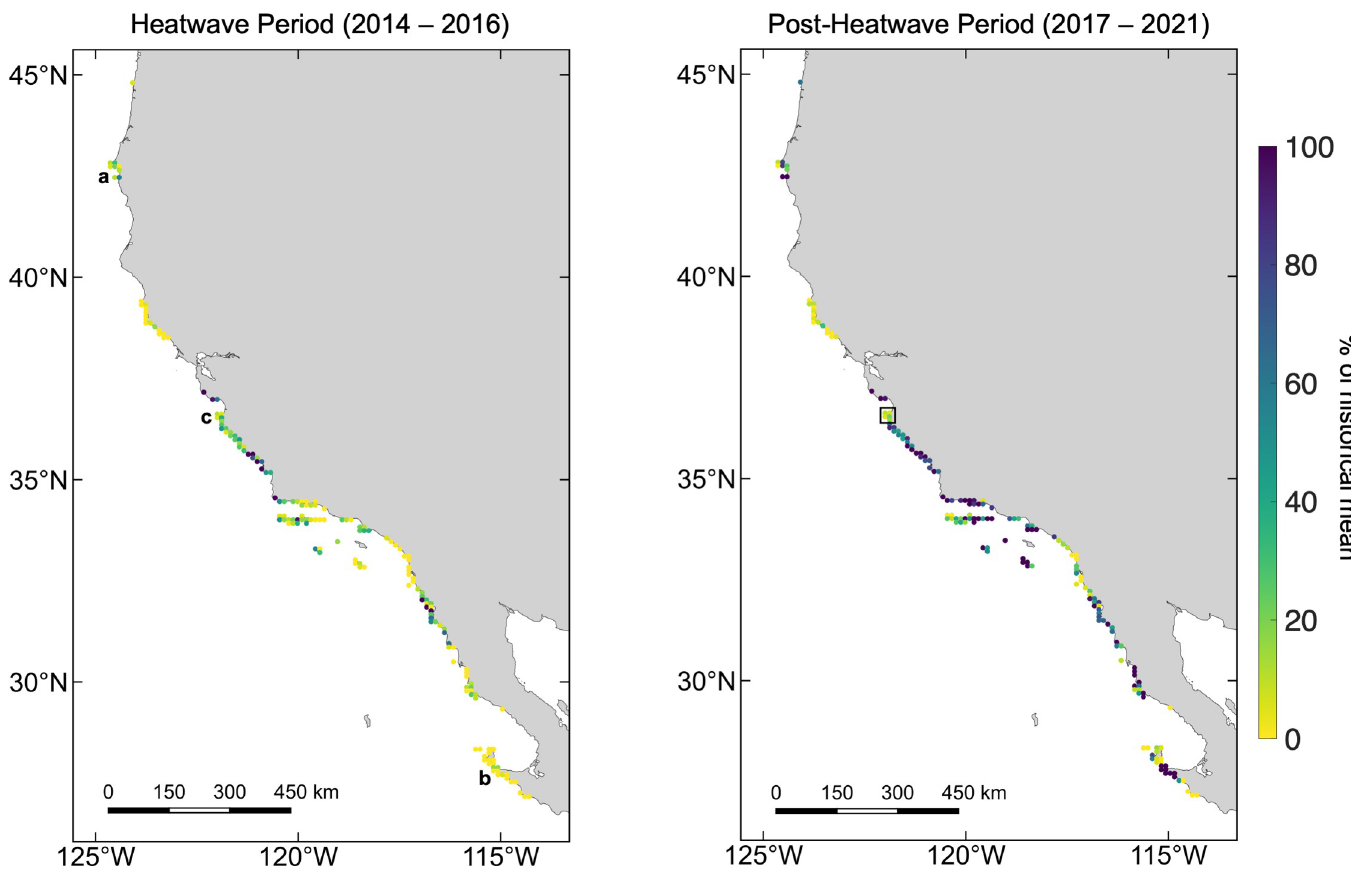
Fig 3. Response to and recovery from the marine heatwave events. Maps of kelp canopy response to the 2014 to 2016 marine heatwave events (minimum annual kelp canopy area remaining during the heatwave period as a percentage of the historical mean) and recovery (mean annual kelp canopy area after the heatwave period as a percentage of the historical mean) within the 10 x 10 km cells for the study domain. The letters correspond to the locations shown in Fig 5. The black box corresponds to the area shown in Fig 6. Basemap source: Natural